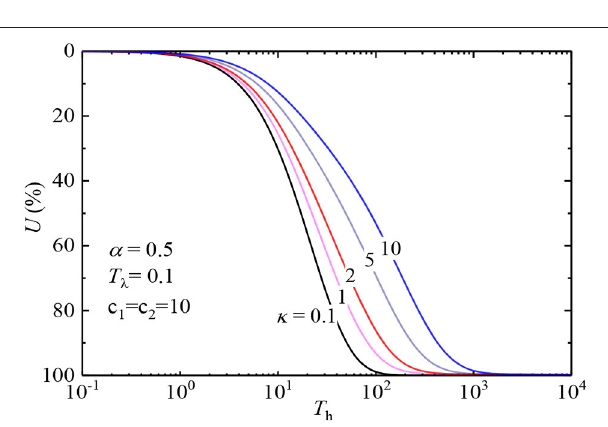
FIGURE 11 | Consolidation process with different values of α . FIGURE 12 | Consolidation process with different values of κ